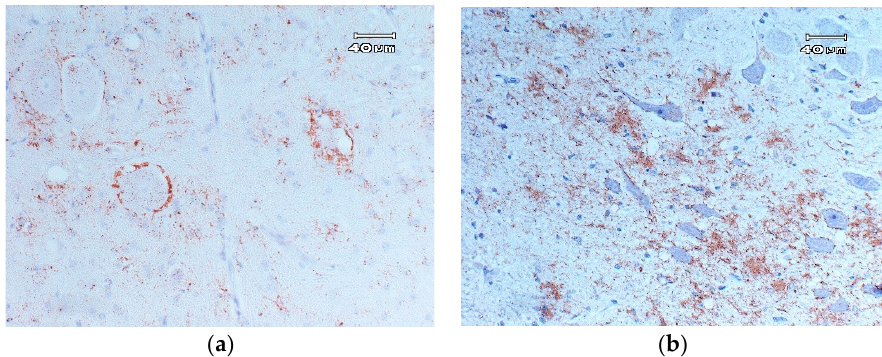
Figure 2. ( a ) PrP Sc intraneuronal and perineuronal immunostaining in neurons located in the brainstem 20×. ( b ) PrP Sc immunostaining in the neuropile of the gray matter located in the brainstem 20×.